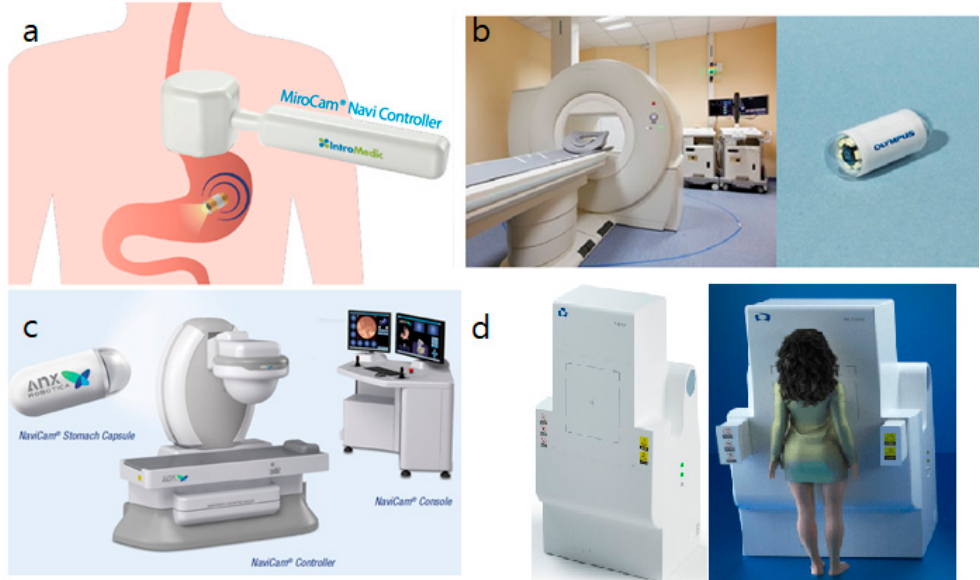
Figure 1. Different magnetically controlled capsule endoscopy systems used in clinical studies: ( a ) hand-held MiroCam-Navi system by Intromedic Ltd. (Seoul, Korea) http://www.intromedic.com, 25 September 2021, ( b ) MCE system developed by Olympus Corp. (Tokyo, Japan) and Siemens Healthcare (Erlangen, Germany) https://www.olympus-global.com, 25 September 2021, ( c ) NaviCam system by AnX Robotica (previously Ankon Technologies, Wuhan, China) https://www.anxrobotics.com, 25 September 2021, ( d ) standing-type MCE by JIFU Medical Technologies (Shenzen, China) http://www.jifu-tech.com, 25 September 2021. Table 1. Systems of MCE used in clinical studies. Table 2. Clinical studies using magnetic guided capsule gastroscopy controlled by hand-held magnet.